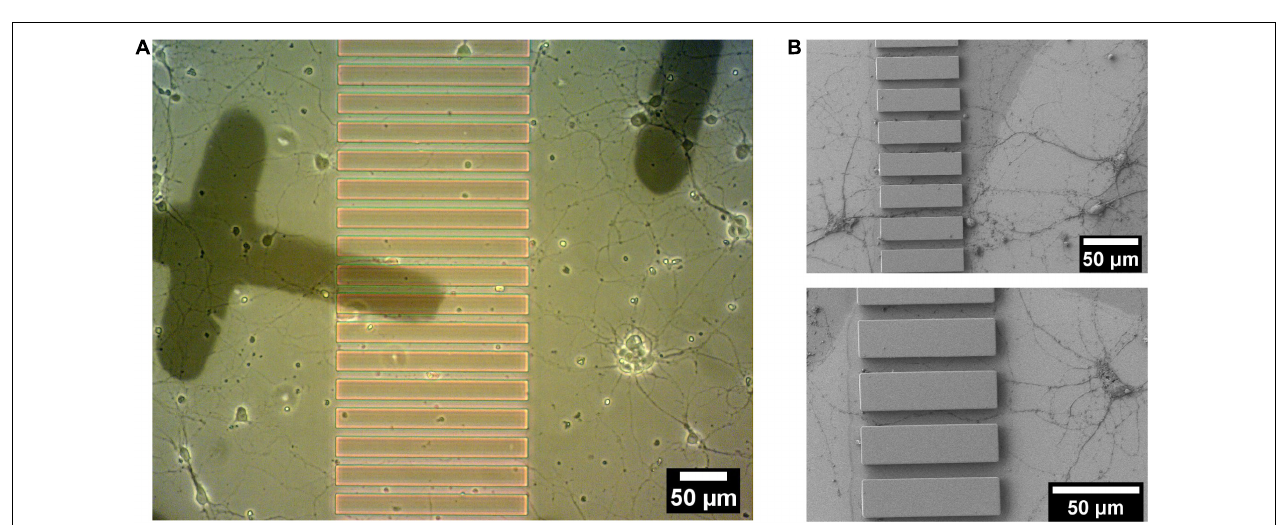
FIGURE 4 | 14 DIV embryonic striatal neurons which were growing on Poly-L-Lysine coated-patterned sapphire disk. (A) Live imaging showed neurites from neurons on both sides of the structure growing into channels. (B) SEM images of the neurites, which were growing into channels. Crossing of neurites over the ridge structures was not observed in any